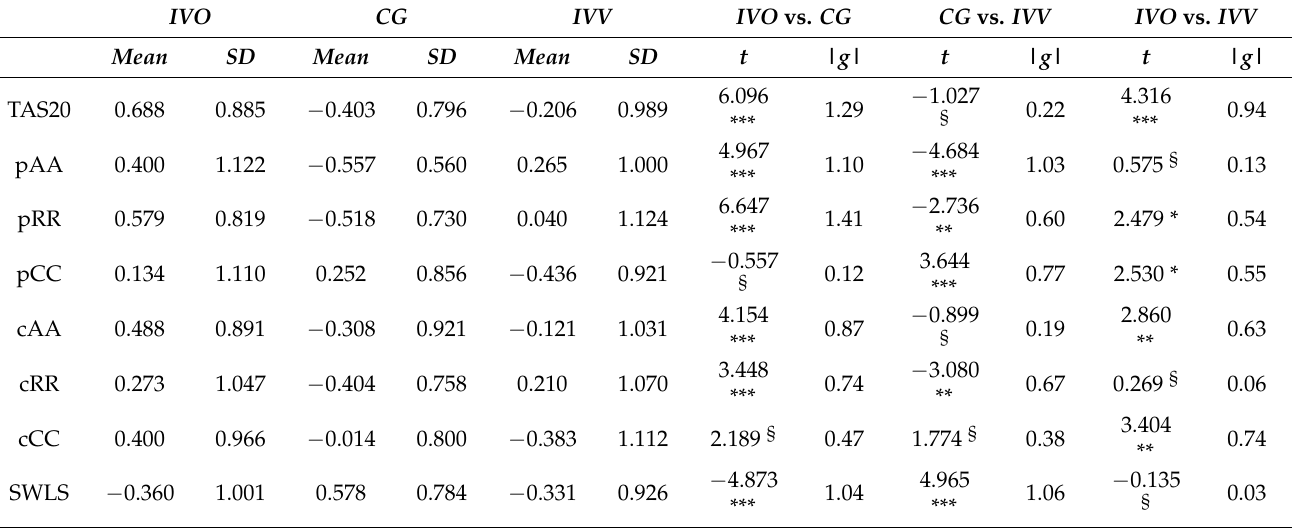
Table 2. Between-group means comparison. Values are expressed as